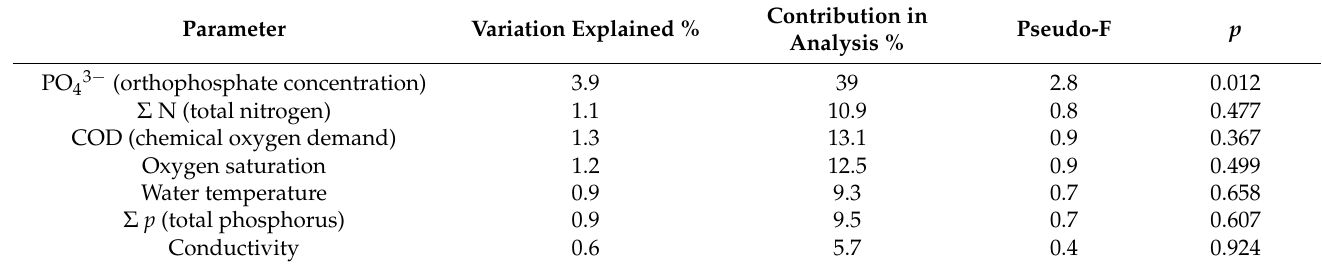
Table 3. Values of individual physico-chemical parameters in CCA “interactive forward analysis in relation to the variability of the water mite assemblages (( i = 7; p =